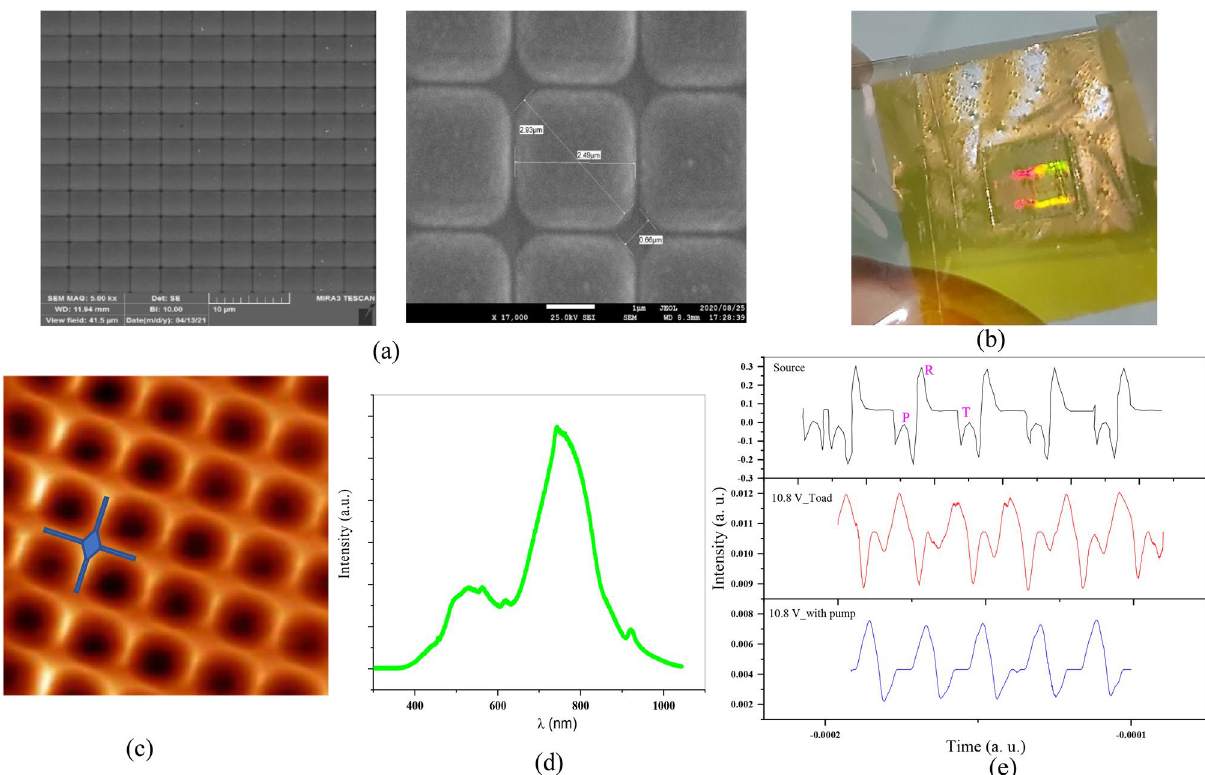
Figure 2. ( a ) SEM image of 2D plasmonic chip, ( b ) real picture of 2D flexible plasmonic chip onto Kapton and ( c ) AFM image of fabricated chip with wires region, ( d ) SLR response of the main 2D plasmonic chip, and ( e ) Heart signal recorded from toad as reference signal 49 , main signal and pumped